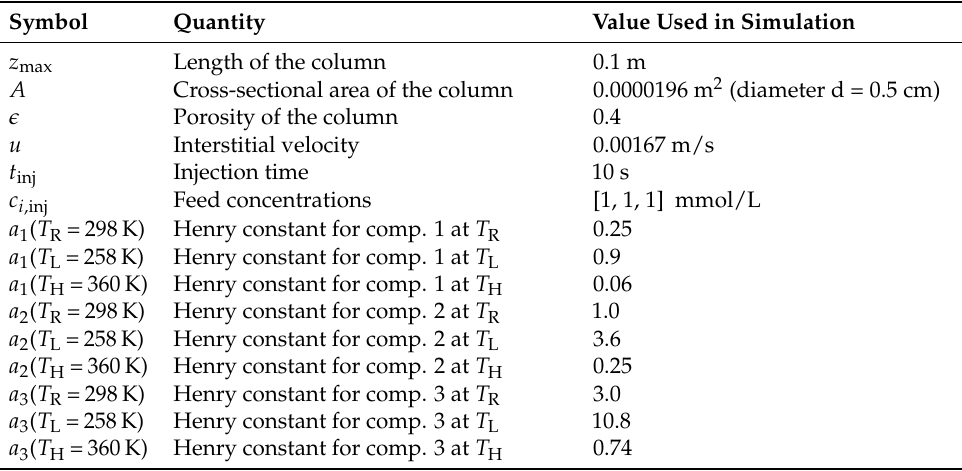
Table 2. Reference parameters used in Section 4.2 (Consecutive injections of multicomponent mixtures).